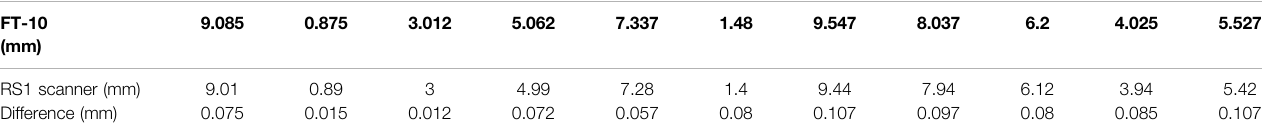
TABLE 5 | Comparison between mean values obtained by means of FT-10 sensor and Romer Absolute Arm 7520 RS1 scanner. FT-10